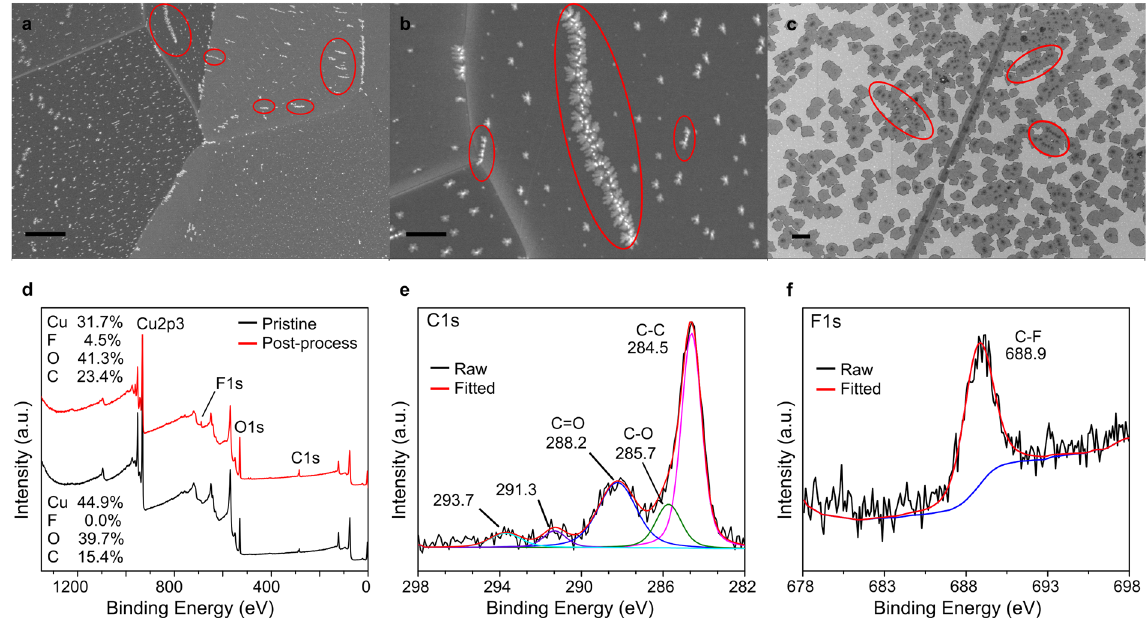
Figure 6. SEM and XPS characterization of a standard CVD growth without methane. ( a , b ) SEM images of the copper surface post-growth, showing the morphology of surface contaminants (red circles; scale bars 10 µ m and 2 µ m, respectively). ( c ) SEM image of a typical growth for comparison, with the highlighted circles showing the morphological similarities between the surface contaminants in ( a ) and ( b ) and the nucleation patterns in ( c ). Scale bar 10 µ m. ( d , f ) XPS spectra of ( d ) the copper surface before and after growth, with surface elemental compositions indicated for each case (in atomic percent), and of the corresponding ( e ) carbon and ( f ) fluorine